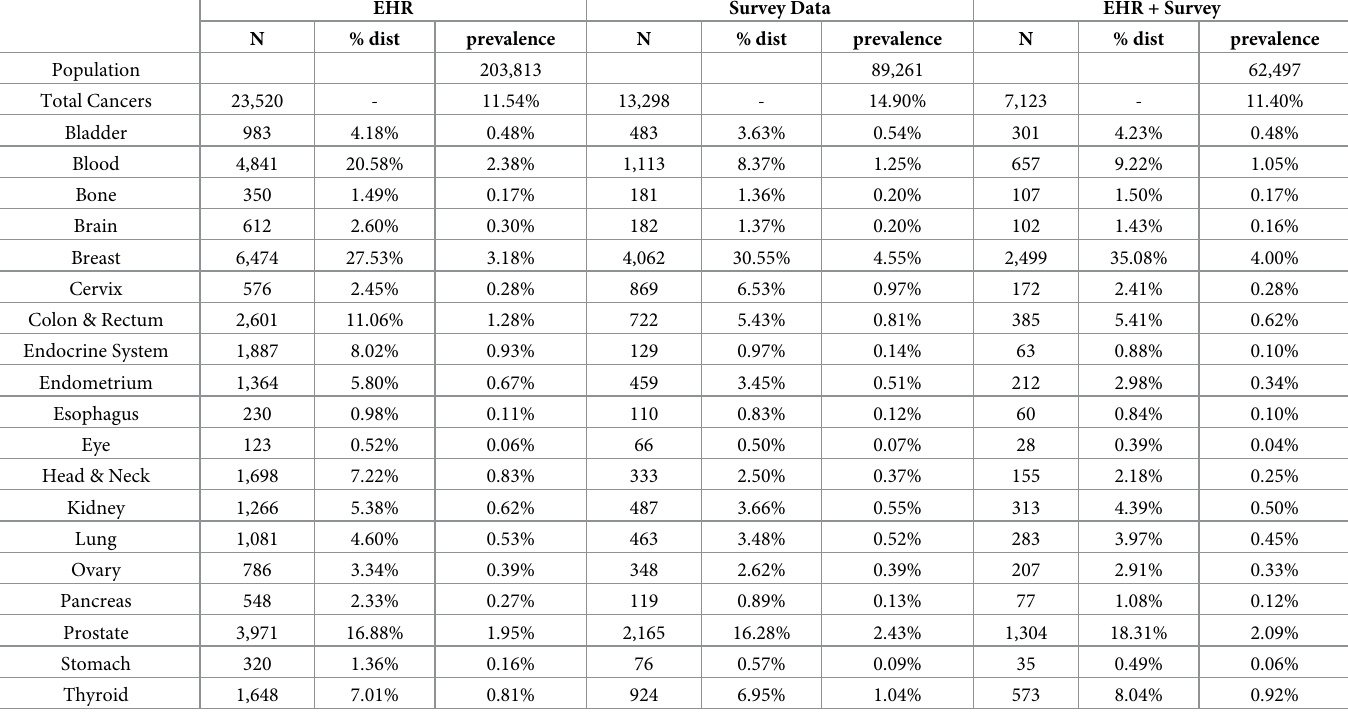
Table 2. The relative distribution and prevalence of cancer cases by type in the All of Us Research Program from self-reported survey data and electronic health record overall.